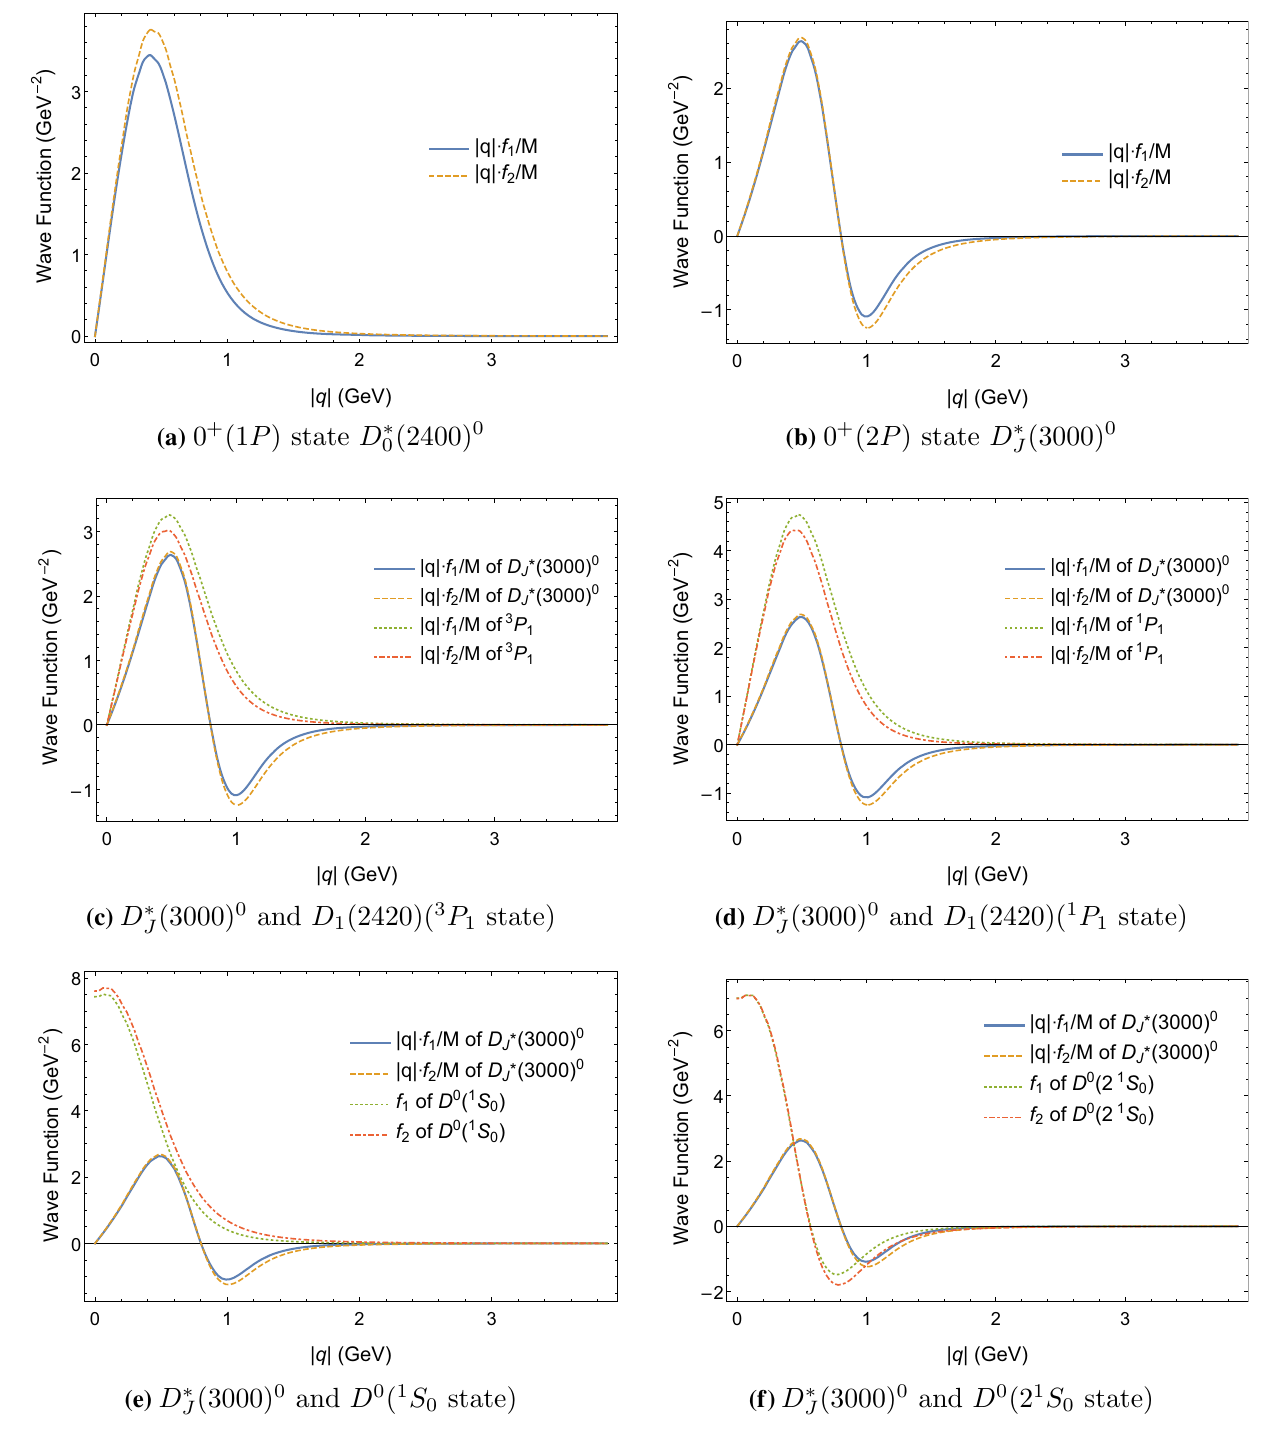
Fig. 4 Several examples of wave functions for some states